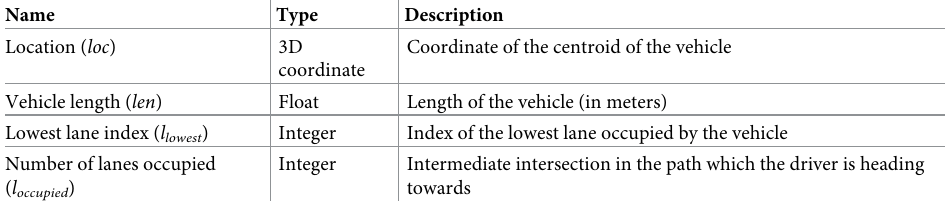
Fig 2. The “lane states” of several vehicles driving on two linked roads. Note that the right-most vehicle is occupying lanes with indices 1 and 2 from its point of view, but the latter is in fact lane 1 on the linked road. https://doi.org/10.1371/journal.pone.0281658.g002 Table 3. Attributes of the vehicle entities related to spatial location.